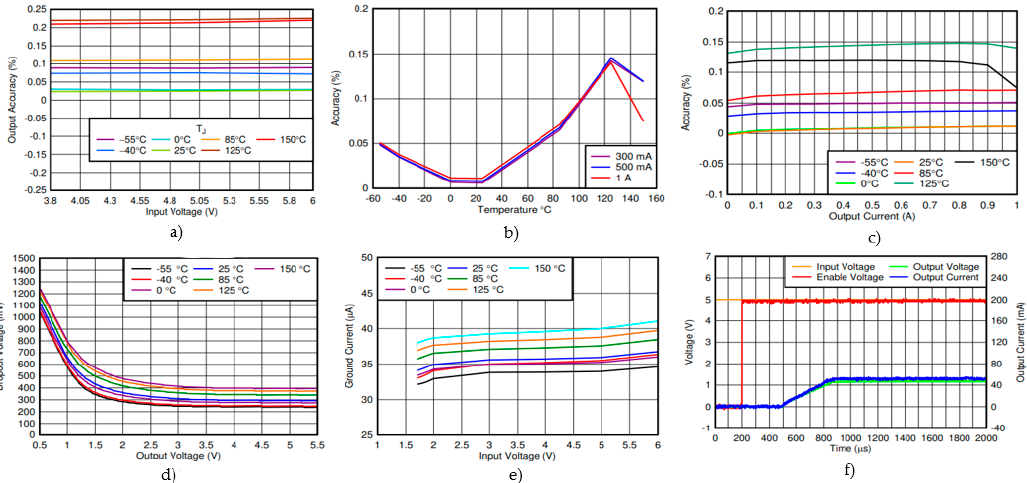
Figure 2. Examples of characteristics for TPS785-Q1: ( a ) output voltage accuracy vs input voltage; ( b ) output voltage accuracy vs temperature; ( c ) output voltage accuracy vs output current; ( d ) dropout voltage vs output voltage; ( e ) ground current vs input voltage; ( f ) output voltage and slew-rates.